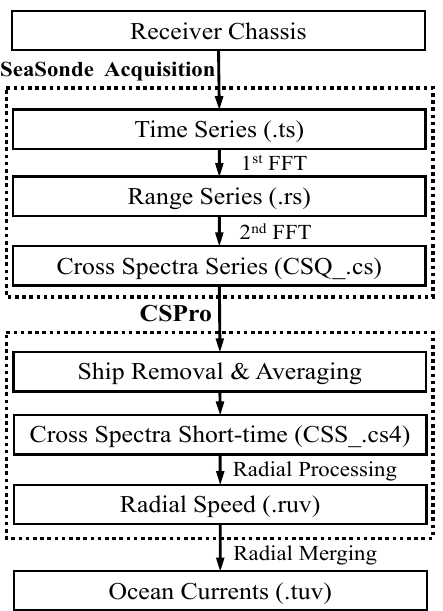
Figure 1. SeaSonde hardware equipment: ( a ) the transmitting antenna (Tx); ( b ) the receiving antenna (Rx), including a monopole and two cross-loop antennas; and ( c ) the central control system.